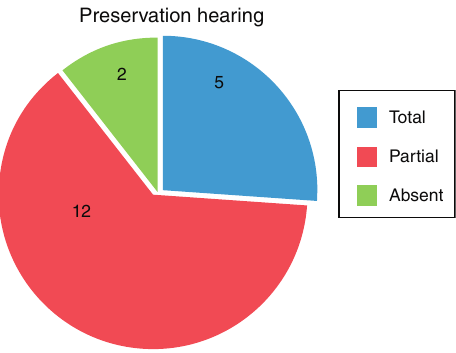
Figure 3 Distribution of patients according to postoperative residual hearing preservation.